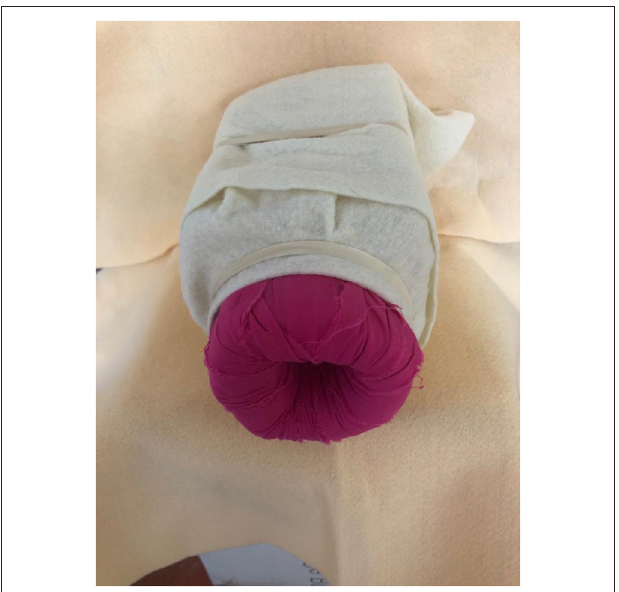
FIGURE 2 | D&E model covered with felt to practice extraction of “fetal parts” by feel.